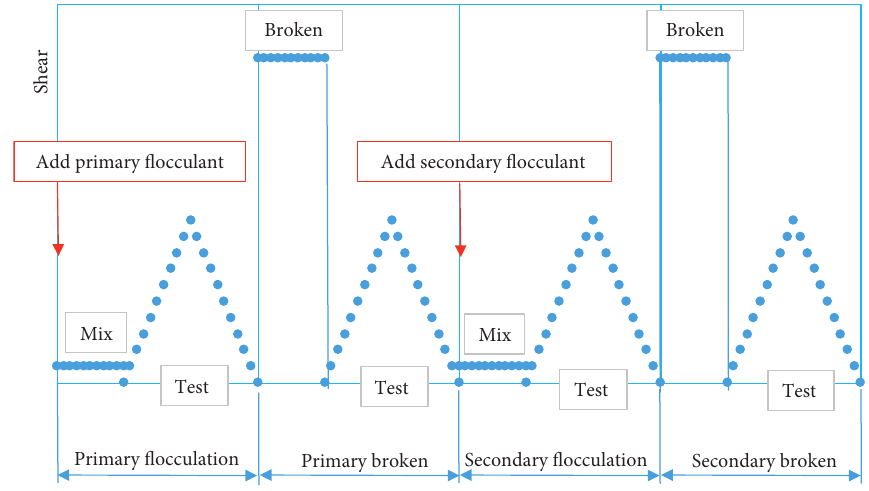
Figure 2: A scheme of rheological